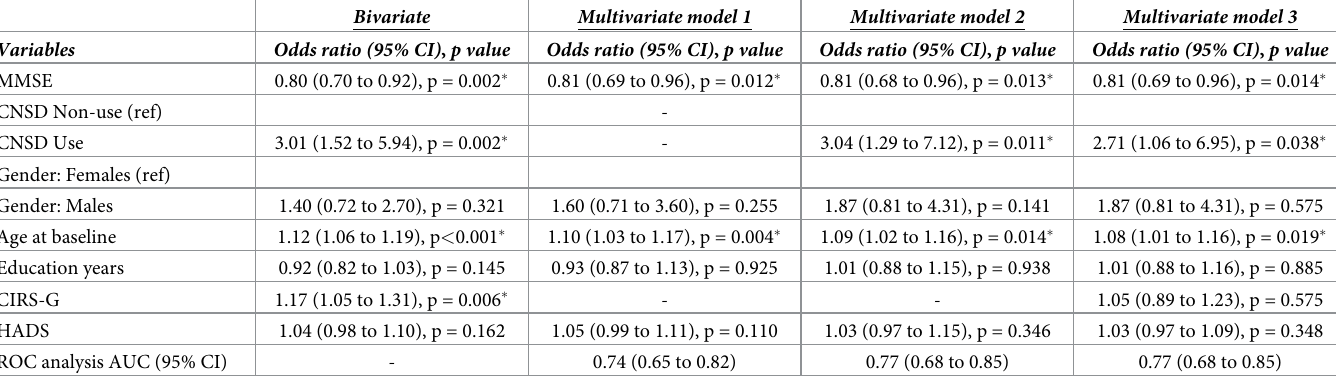
Table 2. Bivariate and multivariate logistic regression models for mortality, with ROC analysis